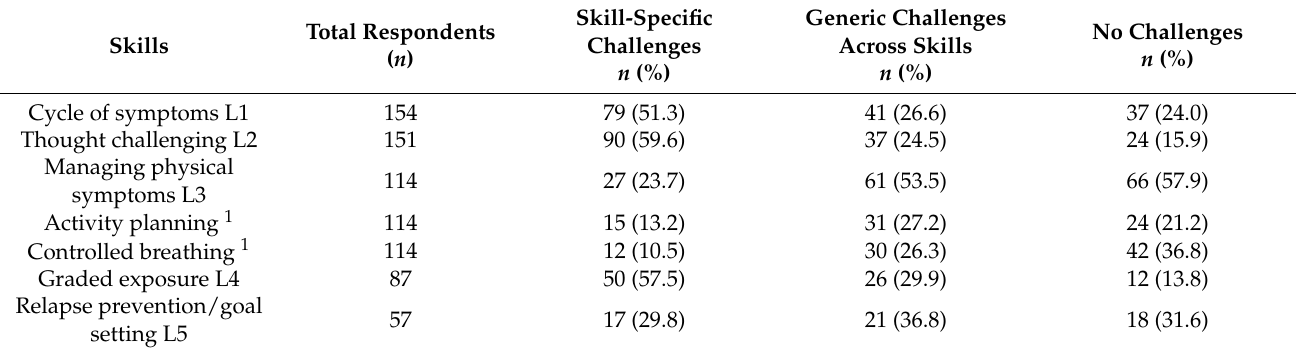
Table 2. Frequency of skill-specific challenges, generic challenges and no challenges per